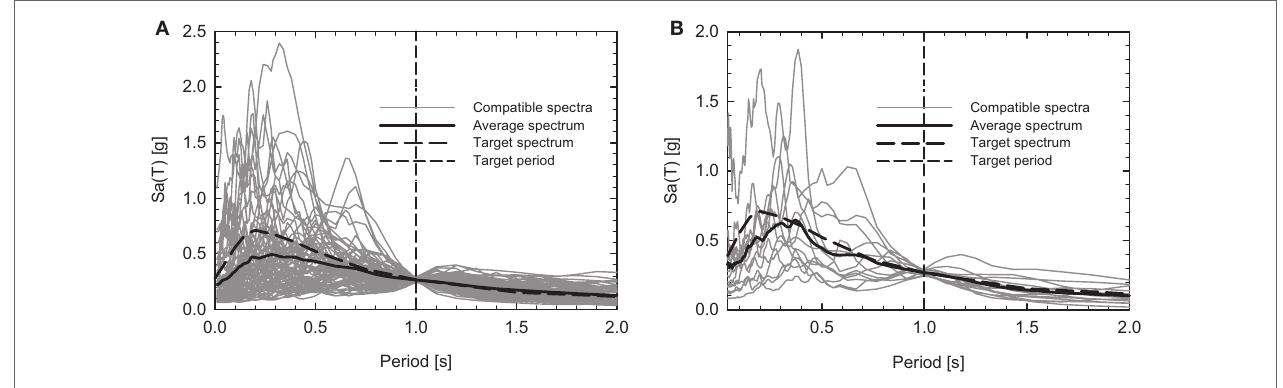
FigUre 7 | Single period matching with uniform hazard spectrum as target spectrum, for the (a) Peer database and (B) esMD .